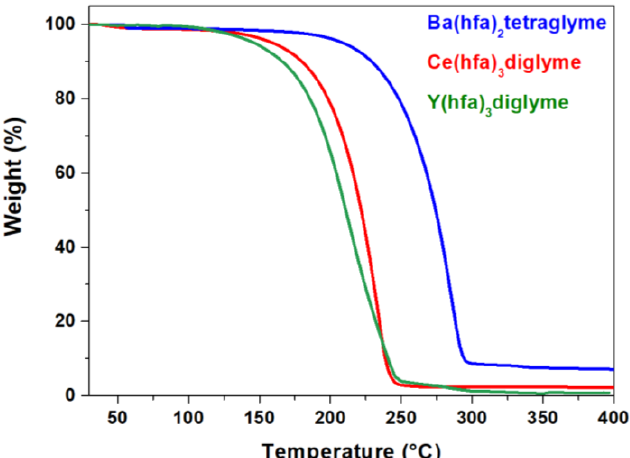
Figure 1. TGA profiles of Ba(hfa) 2 tetraglyme, Ce(hfa) 3 diglyme and Y(hfa) 3 diglyme under N 2 flow at atmospheric pressure, in the temperature range 25 – 400 °C.